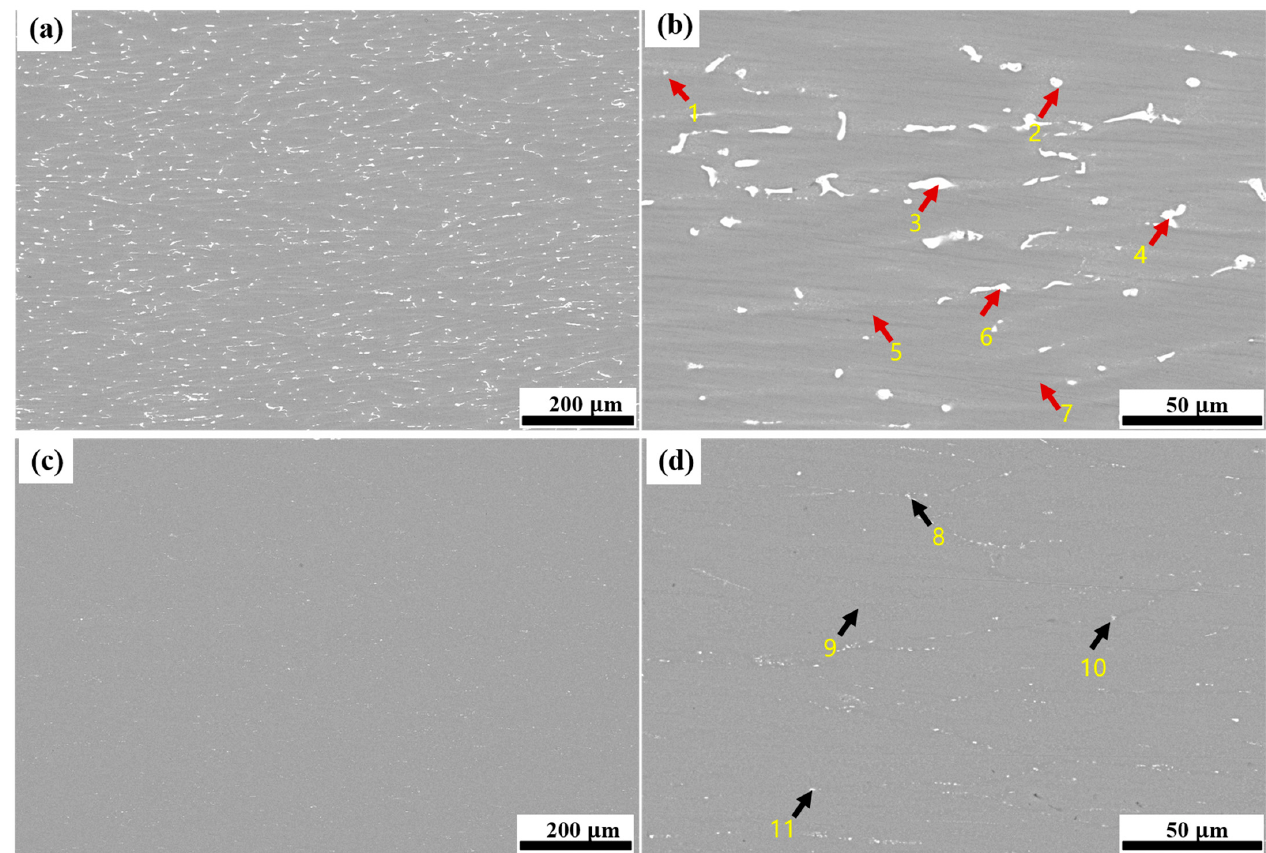
Figure 9. SEM images of ( a , b ) AC and ( c , d ) HG AA2195 Al-Li alloy after hot compression deformation.